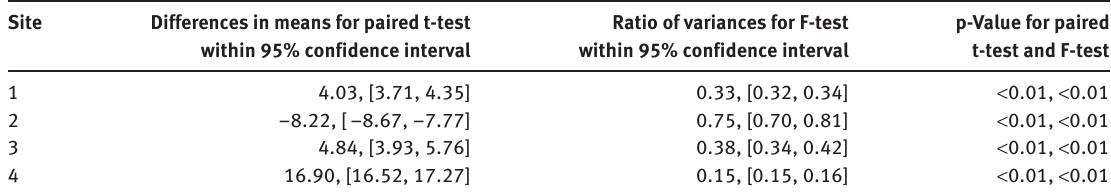
Table 4: Comparisons of Differences between Means and Variances Using Paired t-Test and F-test, p-Value with 95% Confidence Level at Different Sites for the Classes [Motorcycle (C1) and Trucks (C3)].